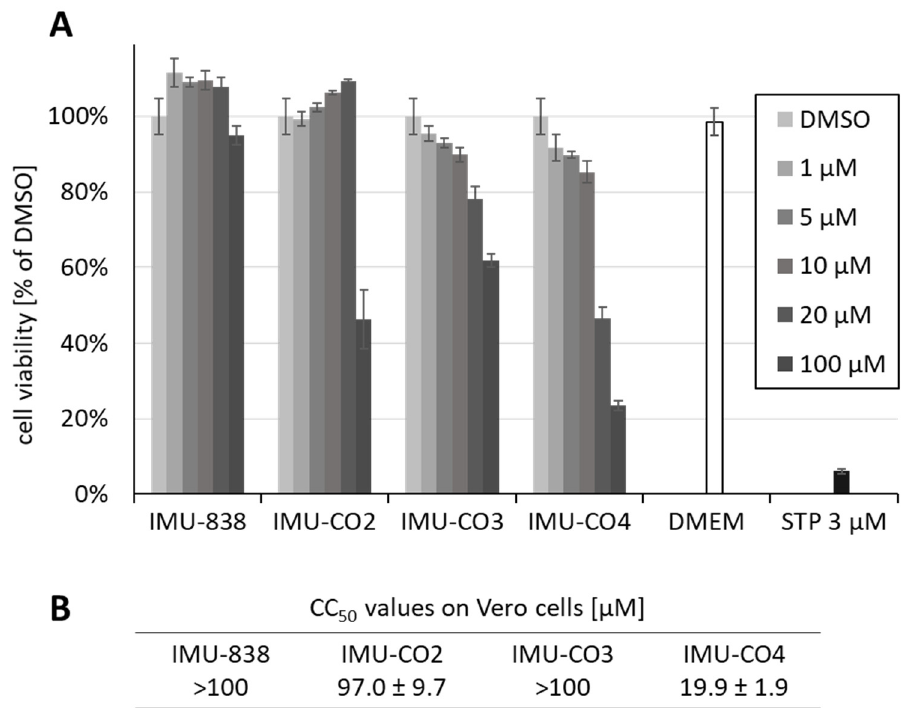
Figure 2. Determination of cytotoxicity levels of IMU-838 and other DHODH inhibitor back-up compounds using the Neutral Red assay (NRA) on Vero cells. ( A ) Subconfluent layers of Vero cells were cultivated in 96-well plates, incubated with the indicated concentrations of IMU-838, IMU-CO2-4, the cytotoxic reference drug staurosporine (STP) or solvent DMSO for 3 days and subjected to NRA measurement in triplicates (Dulbecco’s modified Eagle medium (DMEM), additional medium control). Mean values ± SD are given. ( B ) Levels of cytotoxicity determined for IMU-838 and IMU-CO2-4 on confluent layers of Vero cells under the same conditions as in panel A. Mean half-maximal cytotoxic concentrations (CC 50 values) are given.